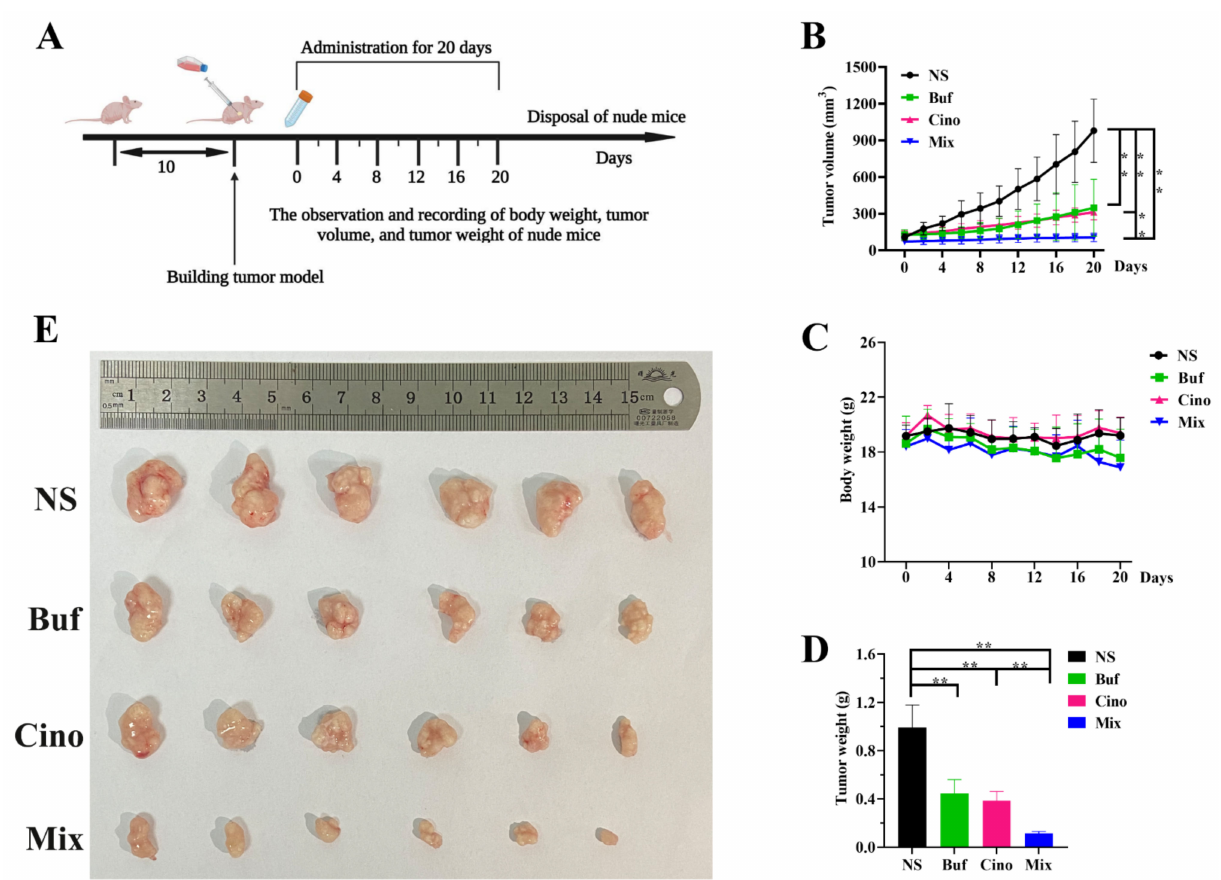
Figure 4. The cotreatment of bufalin and cinobufagin inhibited the HepG2 tumor growth. ( A ) The designed experimental scheme on in vivo nude mice model. ( B – D ) Changes in tumor vol- ume, body weight, and tumor weight during 20 days’ drug intervention. ( E ) The excised tumor images with the treatment of NS, Buf, Cino, and in combination for 20 days. Values were presented as the mean ± S.D., n = 6. “**” means p < 0.01 between two